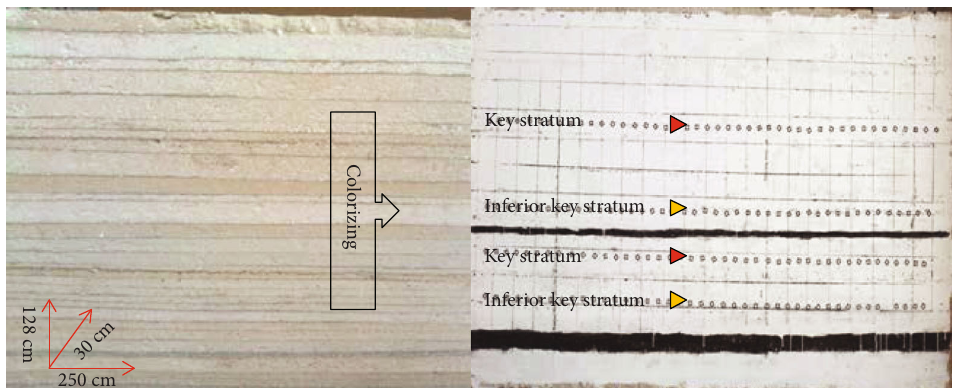
Figure 2: Model layout and key stratum